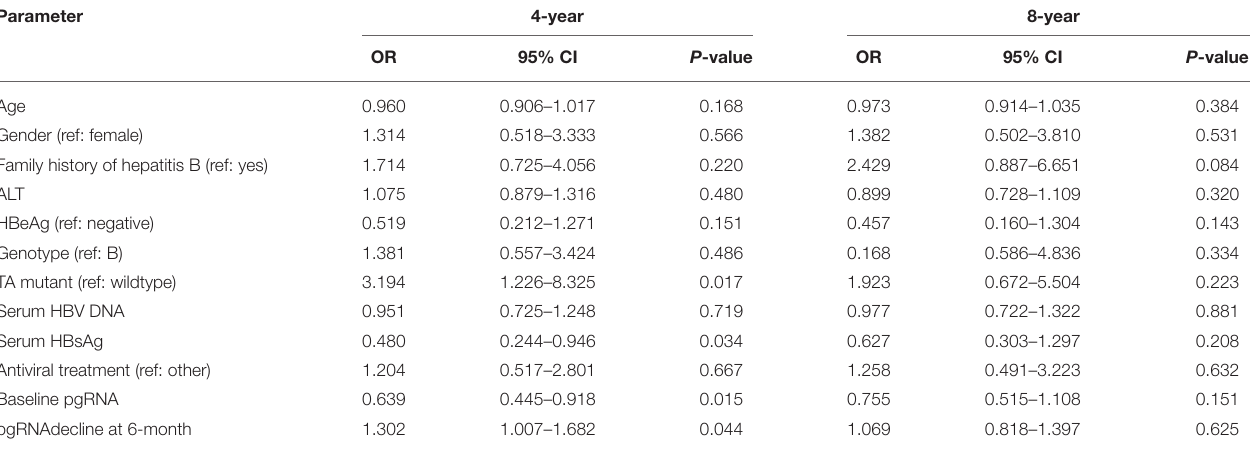
TABLE 2 | Univariable logistic regression analysis of factors associated with undetectable level of serum pgRNA at year 4. Parameter